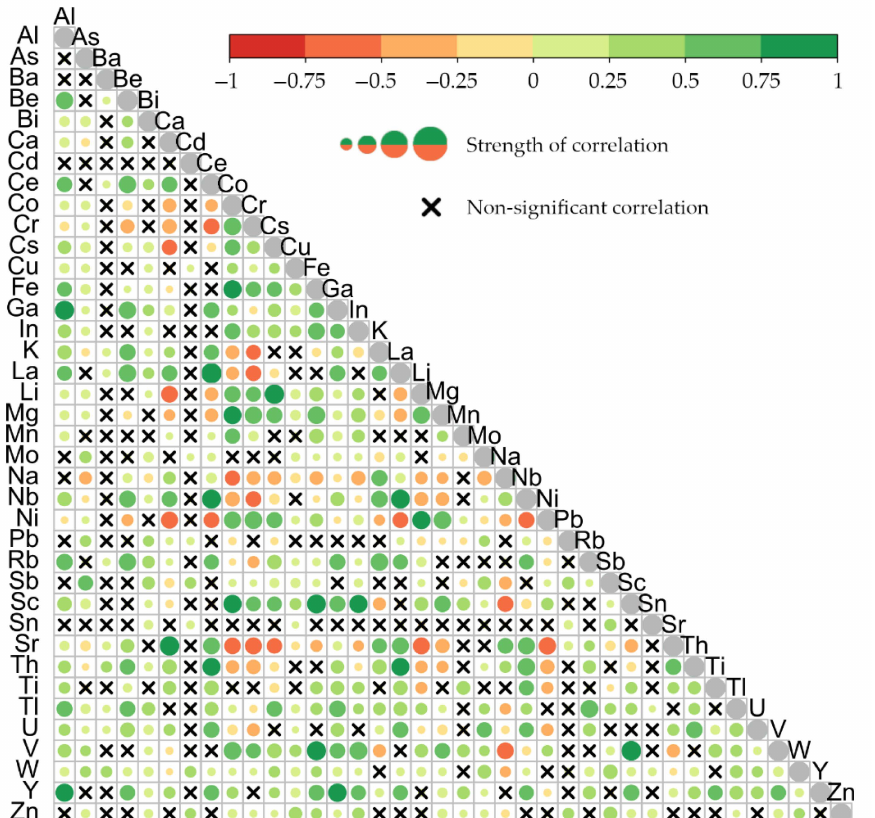
Figure 3. Correlation matrix of the 38 metals studied in the soil samples of the research area. The size and colour of the circles indicate the direction and strength of the correlation (larger indicating stronger correlations, red indicating negative, and green indicating positive correlations). Non- significant correlations are marked with an × .